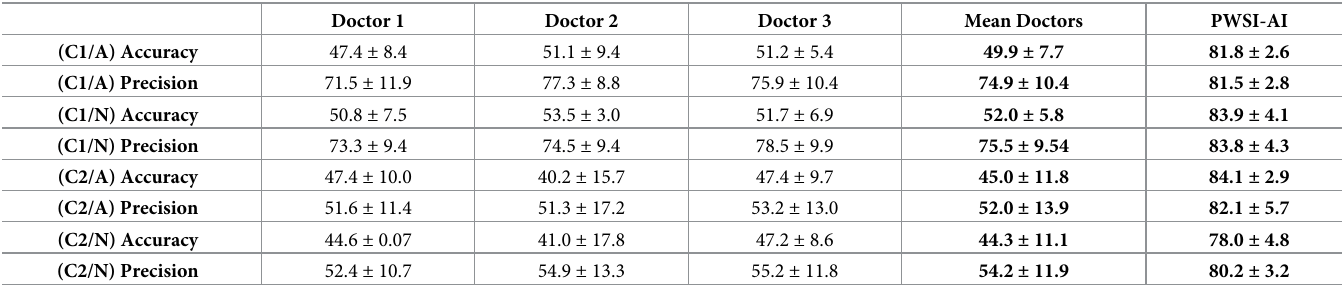
Table 6. Comparison between the proposed PWSI-AI and